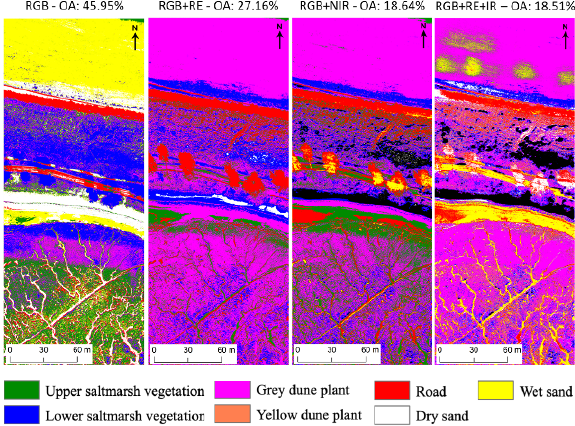
Figure 9. Convolutional neural network classification from the Gram-Schmidt